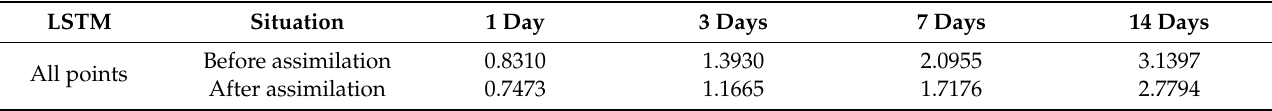
Table 3. Temperature prediction results under different prediction aging after